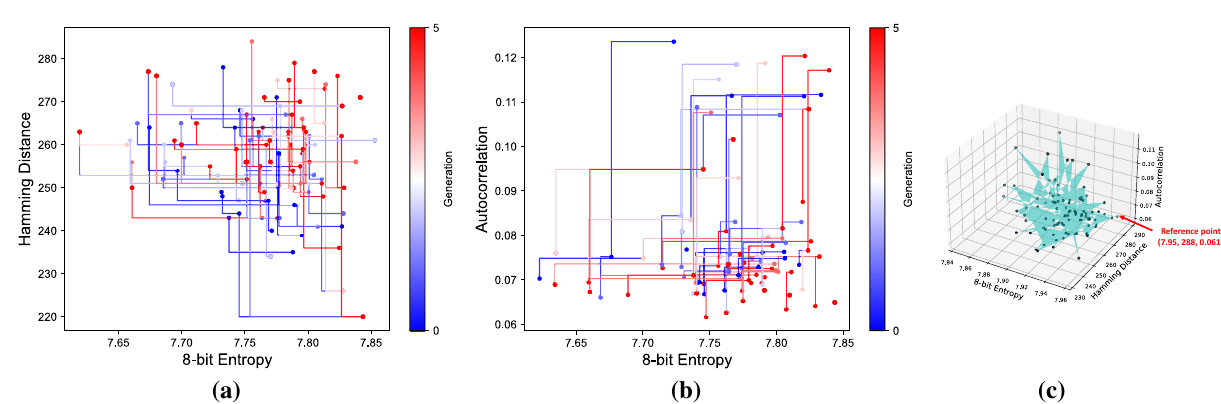
Figure 3. Results of the fitness evaluations with multi-objective and many-objective fitness functions for a 512-bit seed generated by GE-PRNG. ( a ) The Pareto fronts for a multi-objective fitness function made up of F1, entropy, and F2, Hamming distance. This indicates the maximum dissimilarity between any pair of strings generated by GE-PRNG while maintaining the optimal achieved entropy for a particular generation; ( b ) shows the Pareto fronts for a multi-objective fitness function made up of F1, entropy, and F3, Autocorrelation. This experiment validates minimal autocorrelation within a string without impacting the optimal achieved entropy. Finally, ( c ) shows the hypervolume for a many-objective fitness function made up of all three, F1, F2, F3. The combination of all three objectives produces a solution that meets all the prescribed characteristics of an